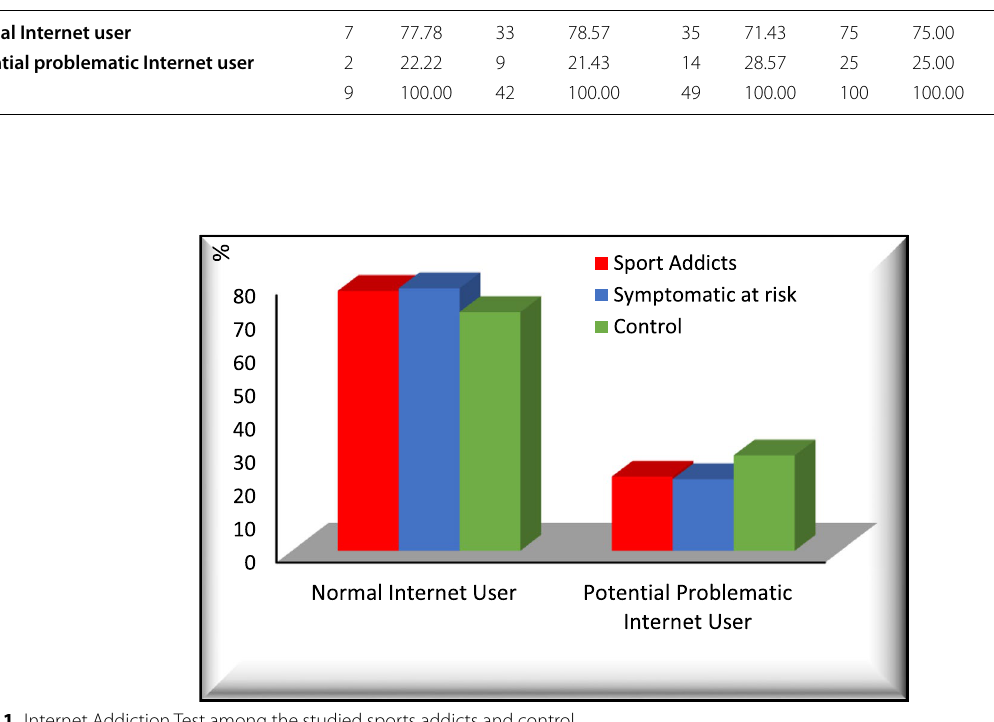
Fig. 1 Internet Addiction Test among the studied sports addicts and